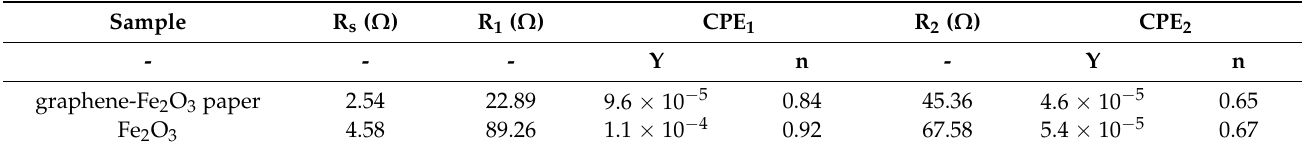
Table 2. The Nyquist diagram is fitted by the equivalent